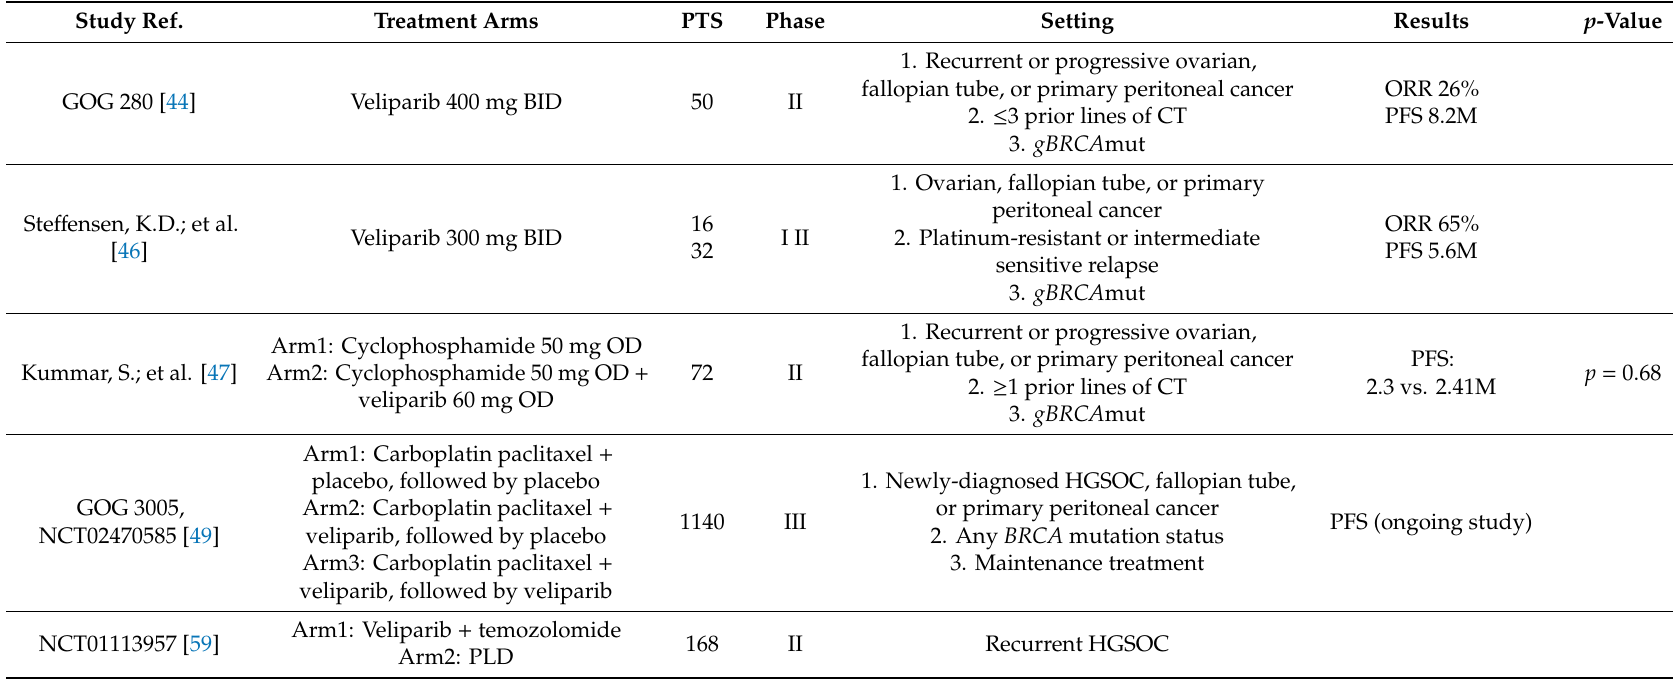
Table 4. Clinical trials results for Veliparib in ovarian